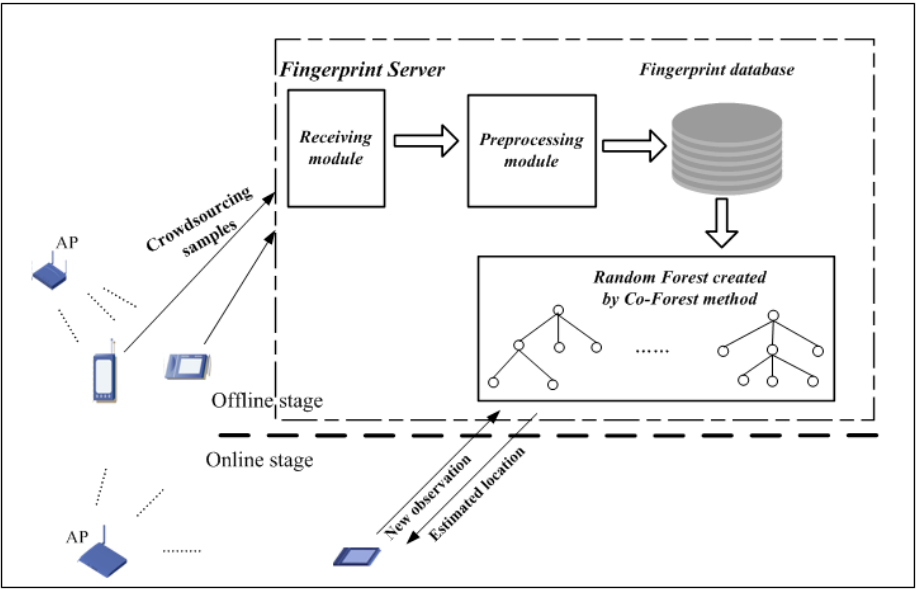
Figure 1. Components of the proposed positioning system.